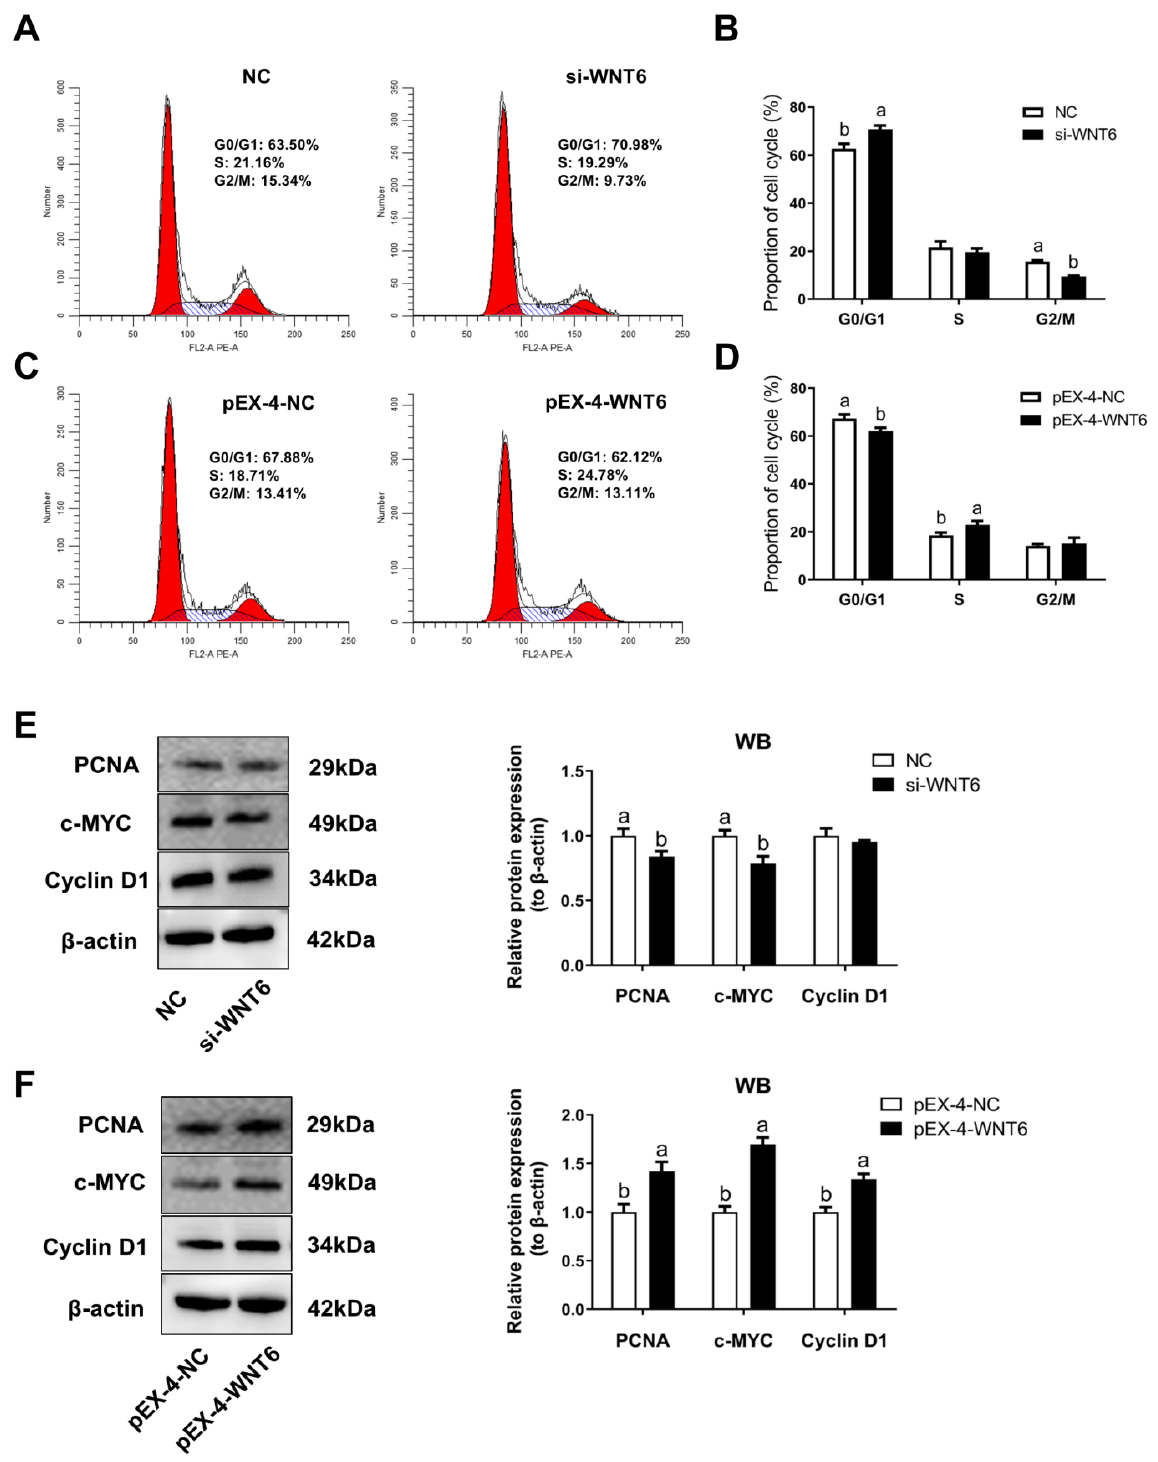
Figure 4. The effect of WNT6 transfection on cell cycle of EECs. ( A , C ) Analysis of cell cycle by flow cytometry. ( B , D ) The percentages of G0/G1, S, and G2/M phases of the cell cycle. ( E , F ) Effects of WNT6 on protein expression related cycle of EECs. NC, Negative control was the siRNA with scrambled sequence absent in the sheep genome. si-WNT6, the small interfering RNA for WNT6 . pEX-4-NC, Negative control of pEX-4 was the empty vector. pEX-4-WNT6, pEX-4 vector with WNT6 -CDs inserted. Values are presented as the mean ± SDs. Means with different letters indicate significant differences ( p < 0.05).